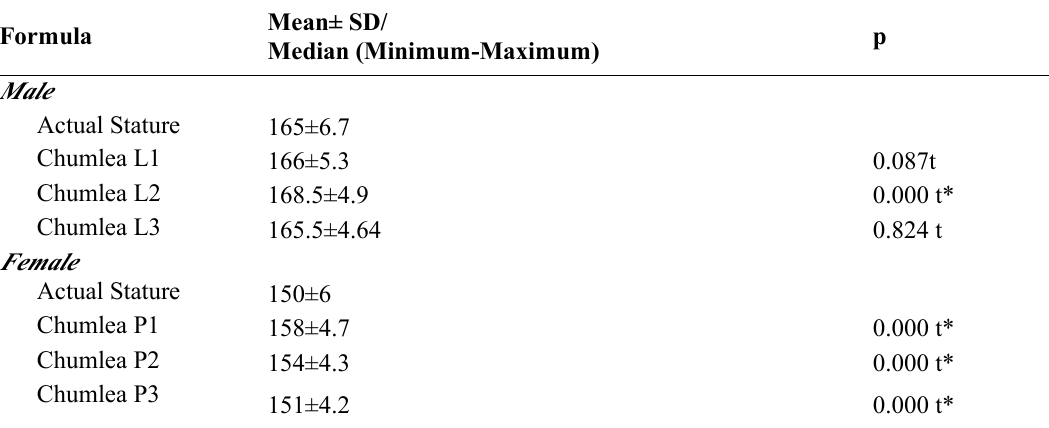
Table 4 Comparation between actual stature and estimated stature using formula